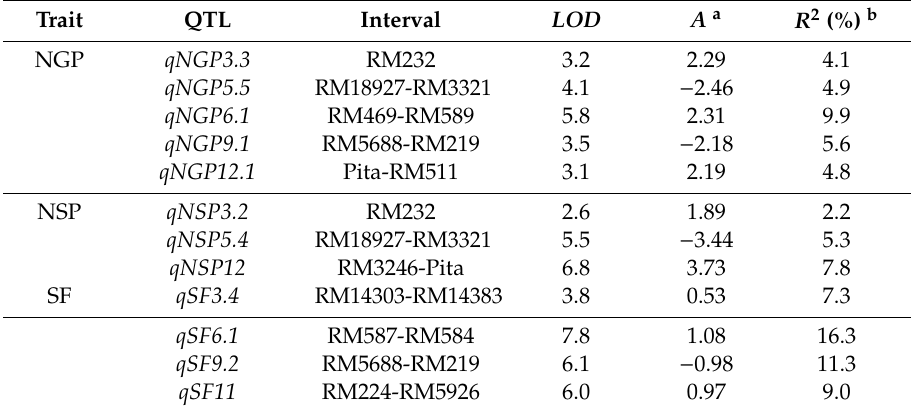
Table 3. QTLs detected for NGP, NSP, and SF in Ti52-2 population.